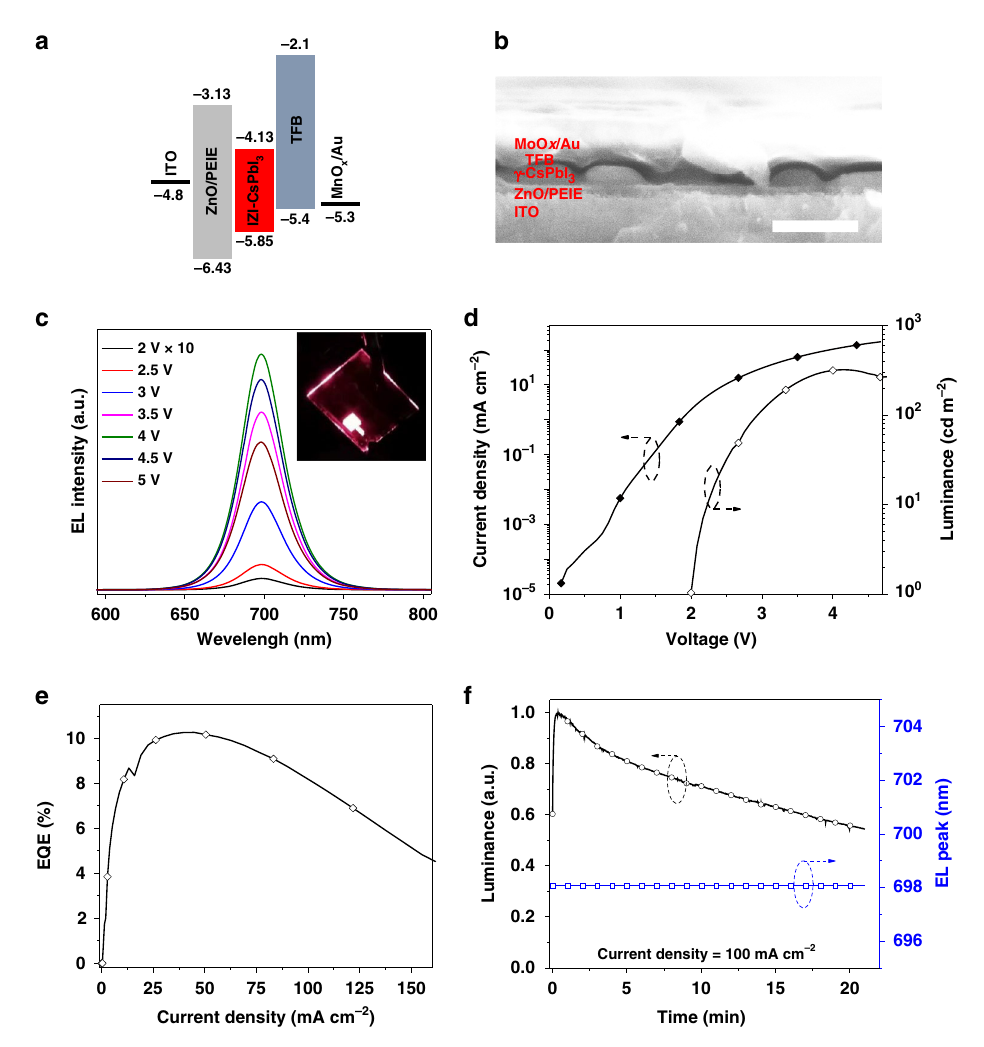
Fig. 4 IZI-CsPbI 3 LED structure and optoelectronic characteristics. a Flat-band energy level diagram and b Cross-sectional SEM image (scale bar, 200 nm). c EL spectra under various voltages. Inset shows the photograph of the deep-red device. d Current density and luminance versus voltage ( J – L – V ). e EQE versus current density ( EQE – J ) curves. f Lifetime and the maximum EL peak position measurement at 100 mA cm − 2 . The maximum EQE as the initial value to calculate the T 50